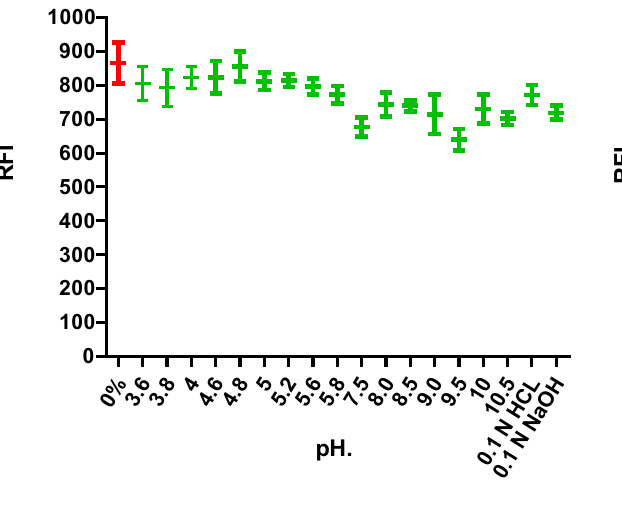
Figure 3: Effect of different pH on the RFI of DCV (60 ng/mL).